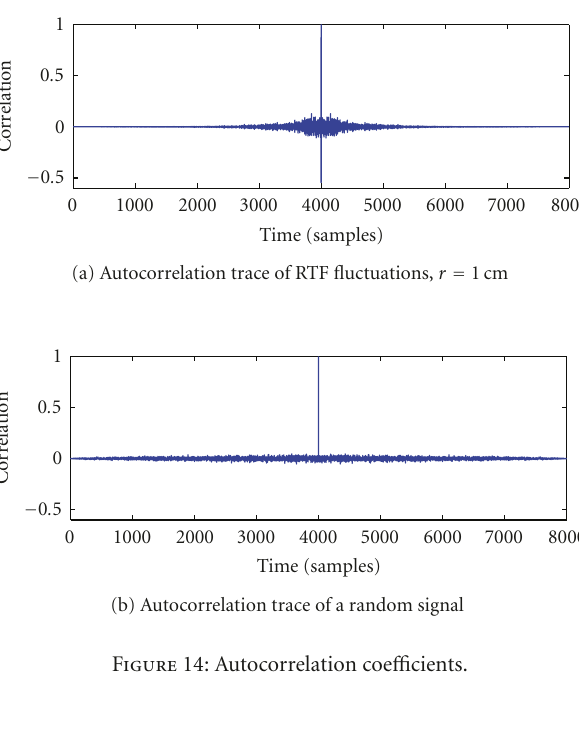
Table 1: Regularization